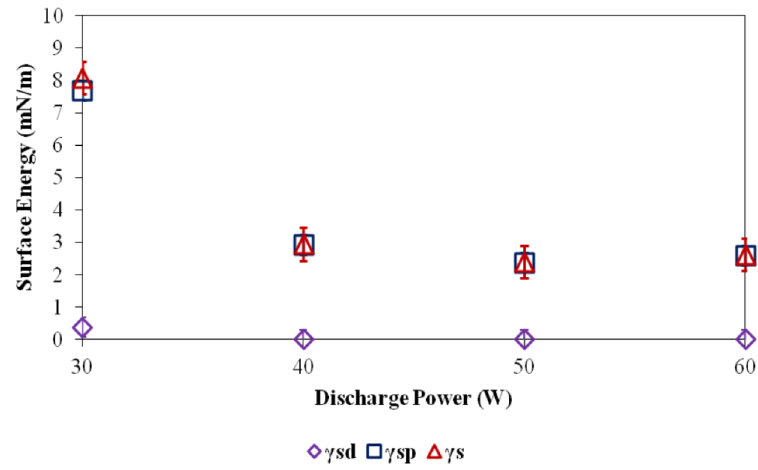
Figure 8. The change of surface energy of TMS plasma modified rayon flock synthetic leather (treatment parameter: amount of TMS = 0.2 mL; flow rate of helium = 12.5 LPM; jet distance = 10 mm; treatment time = 30 s).